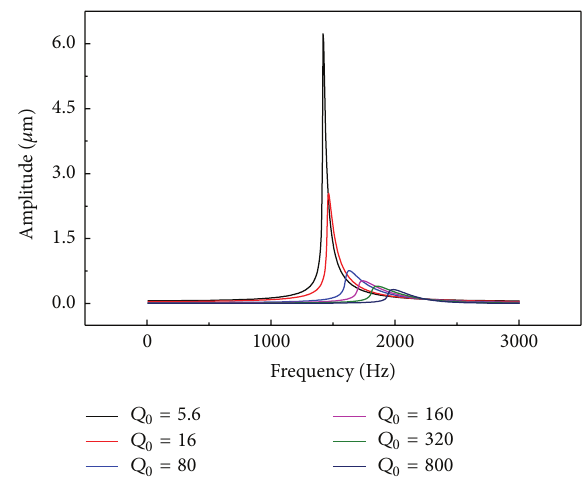
Figure 5: Vibration response of dry friction blade 𝑚 1 with lacing.